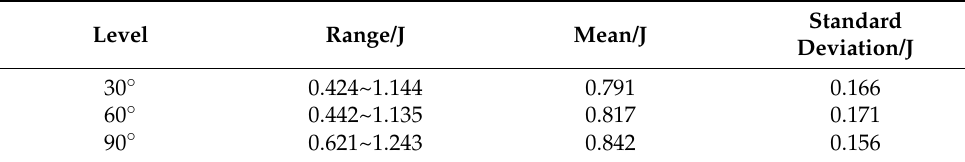
Figure 3. The trajectory of the centre of gravity of the ear before and after collision. Table 1. Ear deformation energy.